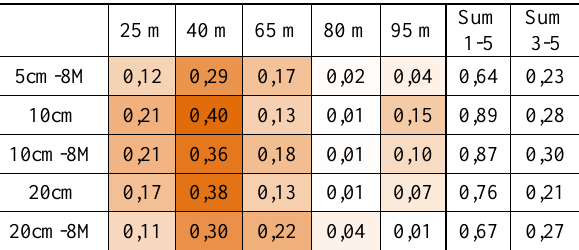
Table 2. Sum of squared differences of optical density values [m -2 ] obtained in fire and aerosol scenarios for particular mesh resolution and computational domain decomposition, evaluated for particular quadruple of detectors at specific distance, summed for detectors 1 - 5 and 3 - 5,